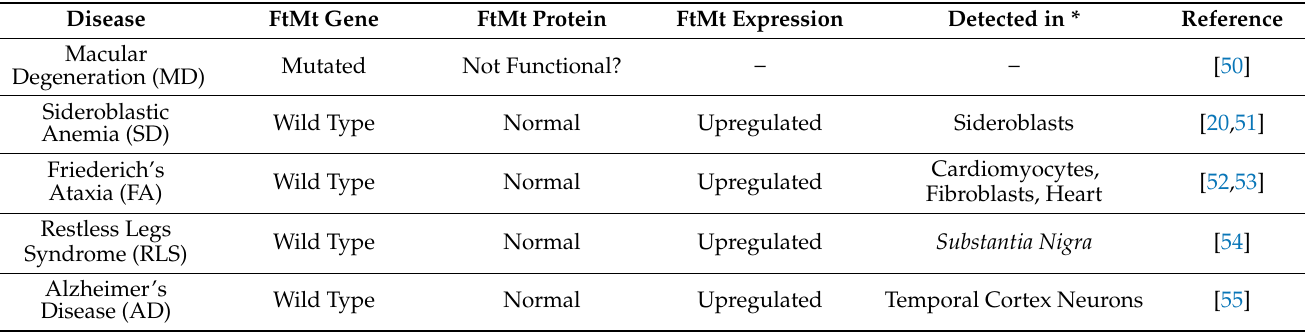
Table 2. Diseases involving